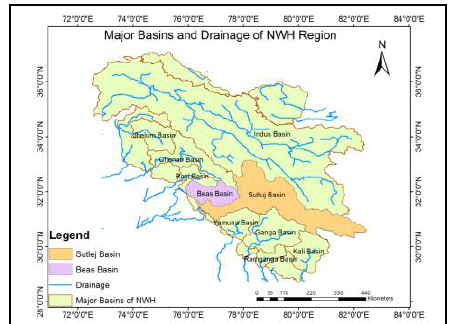
Figure 2: Drainage networks in NWH with highlighted Beas and Sutlej